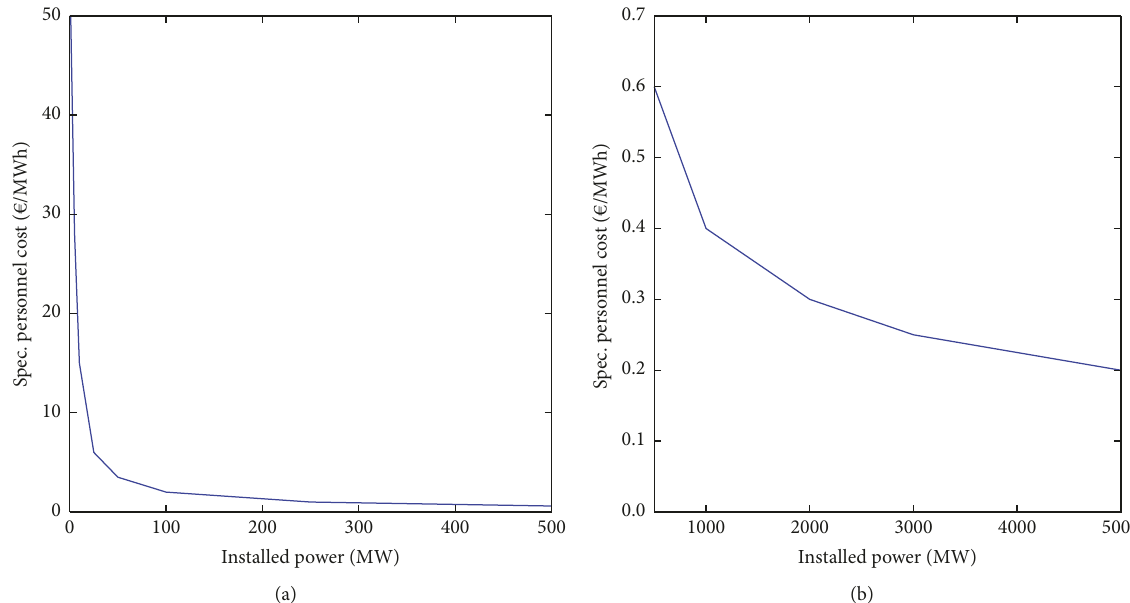
Figure 3: Specific personnel costs 𝑐 per installed capacity of the marketers in the model. Data from [11]. pers , var